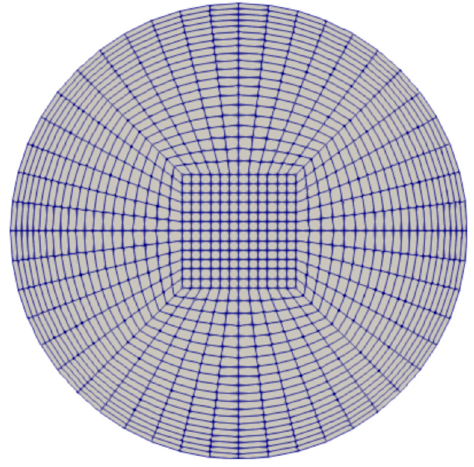
Figure 2. Typical cross-sectional mesh of the tubing.